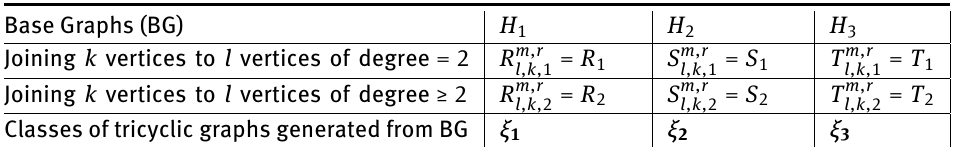
= R 1 S m , r = S 1 T m , r = T 1 l , k ,1 l , k ,1 l , k ,1 = R 2 S m , r = S 2 T m , r = T 2 l , k ,2 l , k ,2 l , k ,2 = X 1 Y m , r = Y 1 Z m , r = Z 1 l , k ,1 l , k ,1 l , k ,1 = X 2 Y m , r = Y 2 Z m , r = Z 2 l , k ,2 l , k ,2 l , k ,2